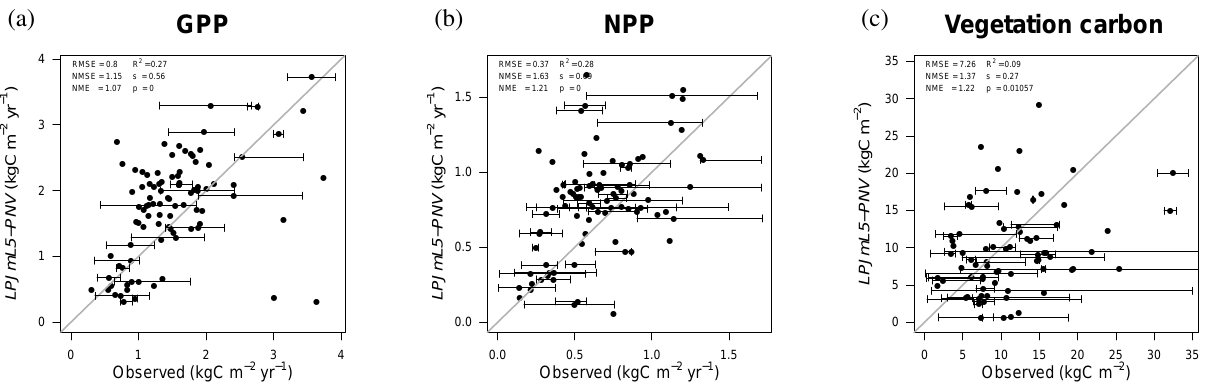
Figure 9. Observed GPP (a) , NPP (b) , and vegetation carbon (c) data (Luyssaert et al., 2007) versus simulated data for natural vegetation ( LPJmL5-PNV ). The horizontal error bars denote the minima and maxima of observed site data belonging to the same LPJmL grid cell and the open dot is the mean. The thin black line denotes the 1:1 line. RMSE: root mean square error, NMSE: normalized mean square error, NME: normalized mean error, s : slope, p :